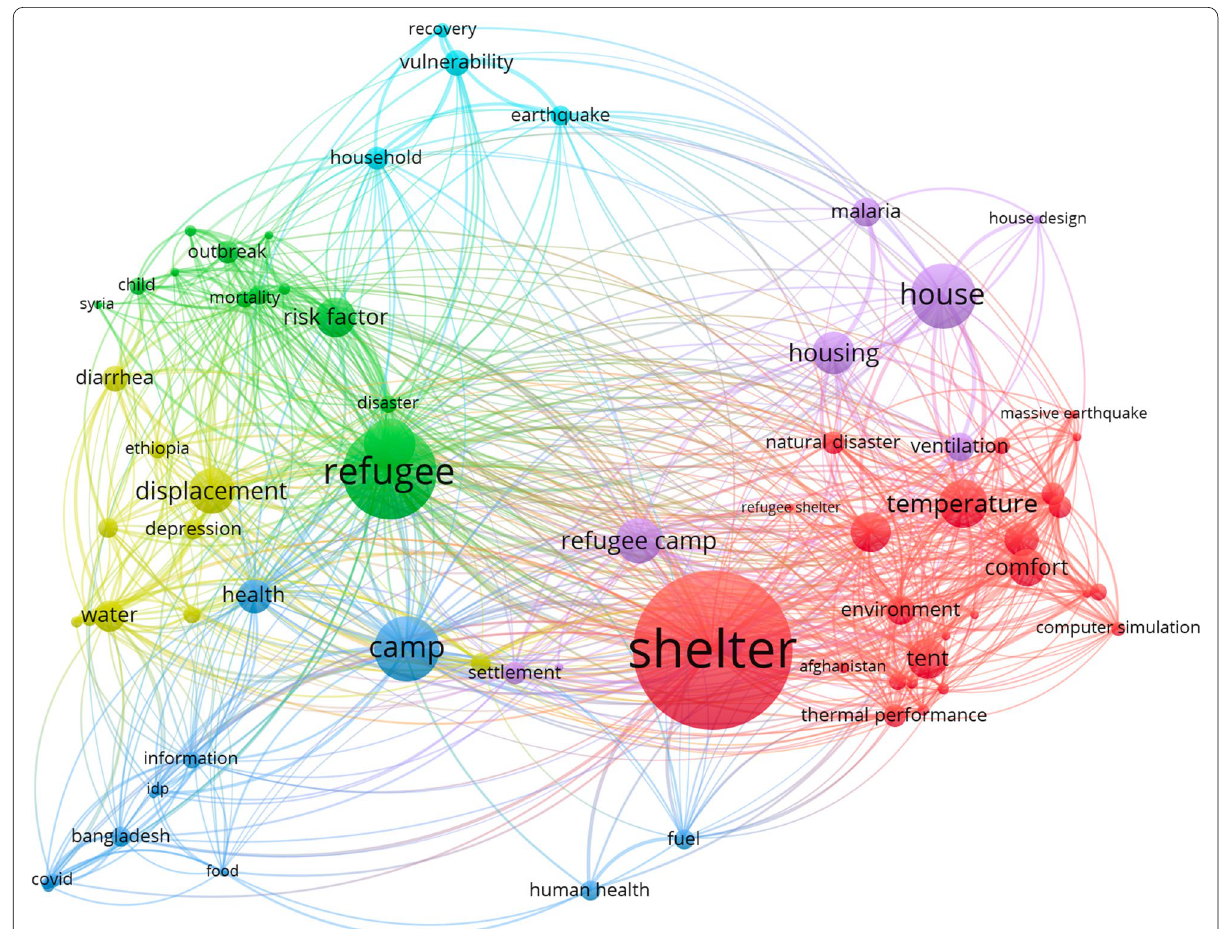
Fig. 2 VOS viewer co-occurrence network visualisation mapping of the most frequent keywords (minimum of three occurrences) in shelter and